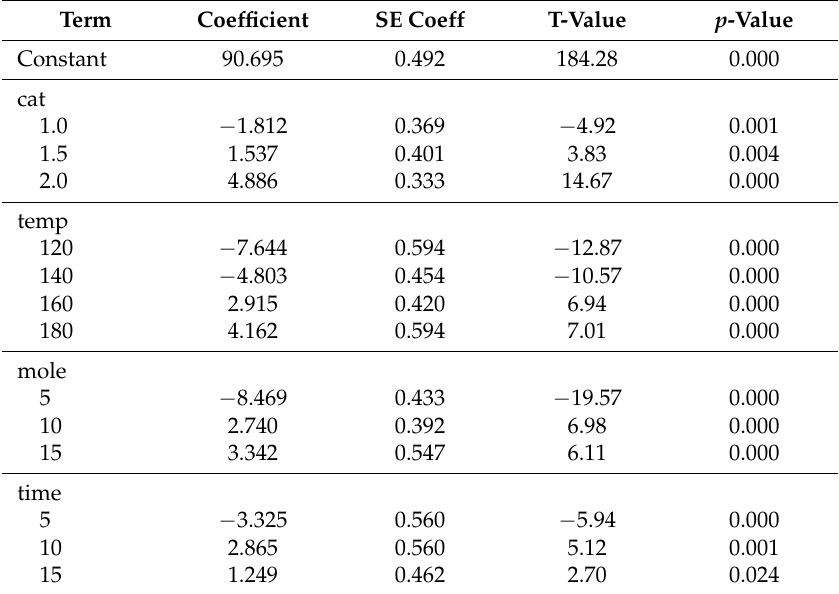
Table 6. Regression coefficient estimation for the biodiesel yield from the waste cooking